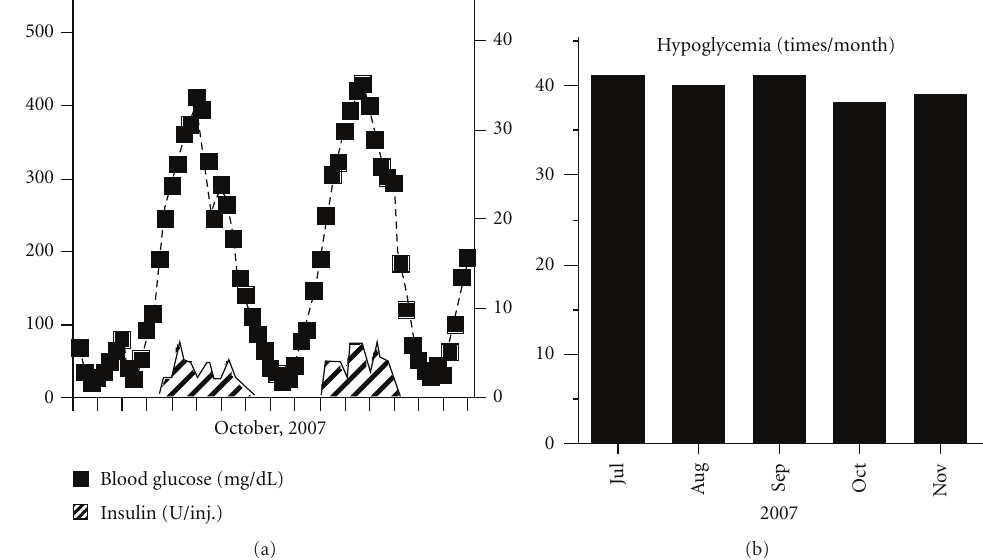
Figure 1: Representative blood glucose profiles before treatment. Blood glucose profile and the dose of each insulin injection are shown (a). The duration between ticks on the X -axis represents 24h. The frequency of hypoglycemia, defined as below 70mg/dL of blood glucose, is shown (b).